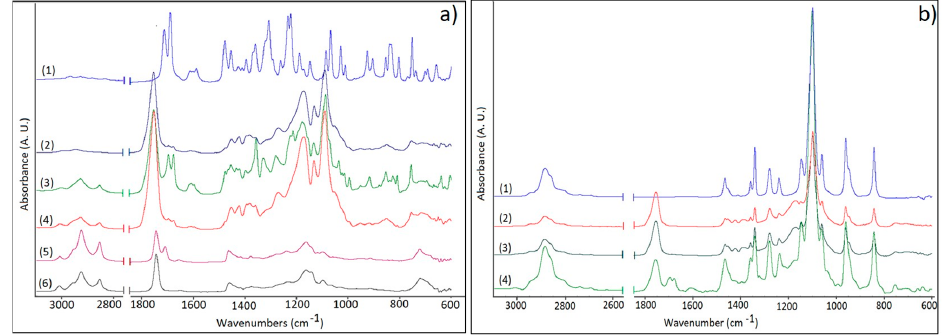
Figure 5. ( a ) FTIR spectra of (1)–IMC, (2)–PLGA-IMC, (3)–HPON-IMC, (4)–HPOE-IMC, (5)–NSO, and